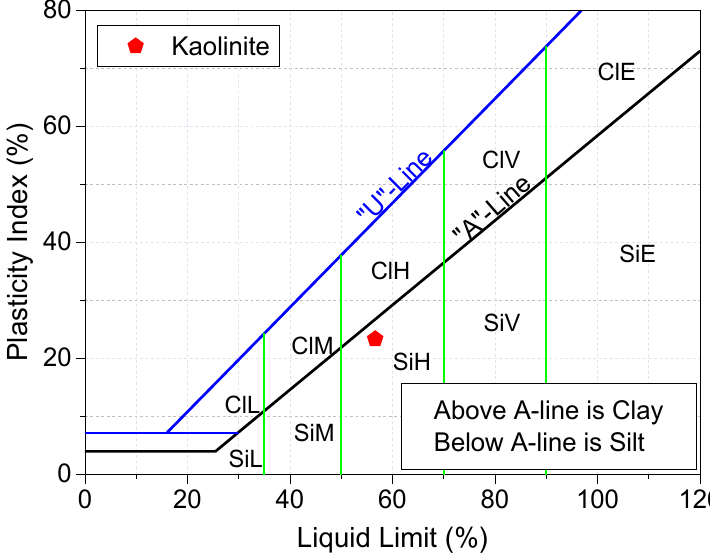
Figure 2. Classification of kaolinite (K), based on the plasticity chart. Gypsum was calcium sulfate dihydrate, in the form of a fine white powder with a percentage purity of ≥ 98% and water solubility of 2 g/L (20 °C). It was produced by precipitation from an aqueous solution and obtained from Fisher Scientific Ltd., Lough- borough, Leicestershire, Leicester, UK. Lime was quicklime, in the form of an off-white, finely odourless powder with a relative density of 3.31 and supplied under a trading name of lime-base quicklime by Tarmac Cement and Lime Company, Buxton Lime and Powders, Derbyshire, Derby, UK. Silica fume was a commercially highly reactive micro-silica, in the form of a light grey amorphous power with a SiO 2 content of 98.4%. It was manufactured by Elkem Silicon Materials in Norway [32], and supplied by Tarmac Cement and Lime Company, Buxton Lime and Powders, Derbyshire, Derby, UK, under the trading name of Elkem un-densified micro-silica 971. Figure 1 shows the particle size distribution curves of the raw materials, while Tables 1 and 2 summarise the oxide compositions and physical properties